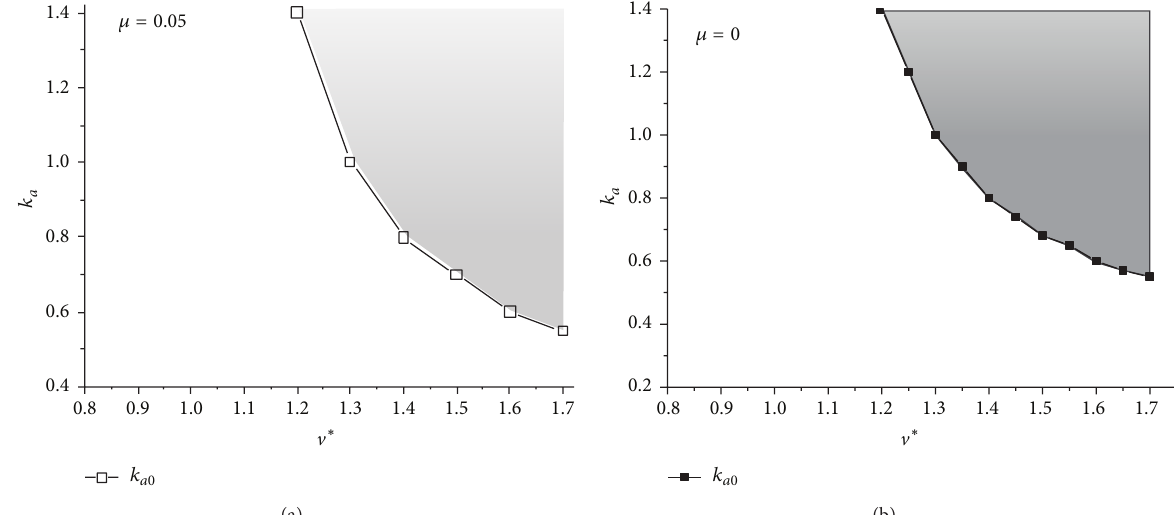
Figure 6: The scope of 𝑘 𝑎 for the emergence of the key property. The grey area represents the set of parameters ( 𝑘 𝑎 , V ∗ ) that enable the model to possess the key property. Initial conditions: 𝑦 ∗ 𝑠 = 1 and 𝑝 = 1.0